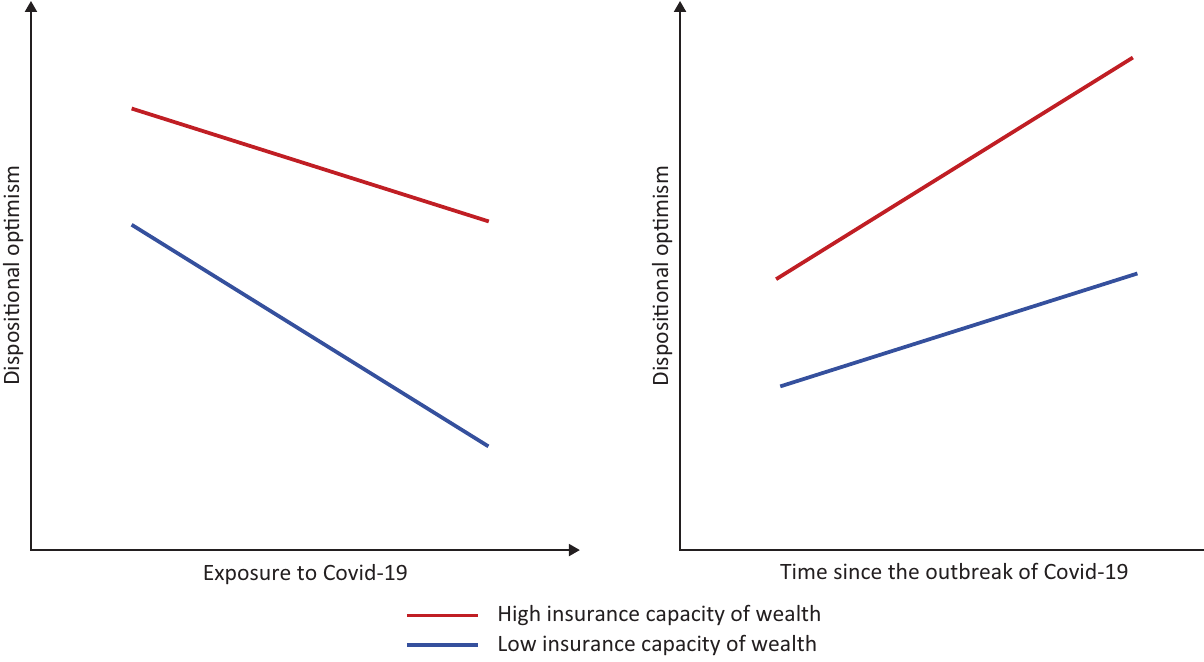
Figure 1. Illustration of research hypotheses linking the insurance capacity of wealth with socioemotional responses to Covid‐19: Divergent susceptibilities (left) and divergent growth